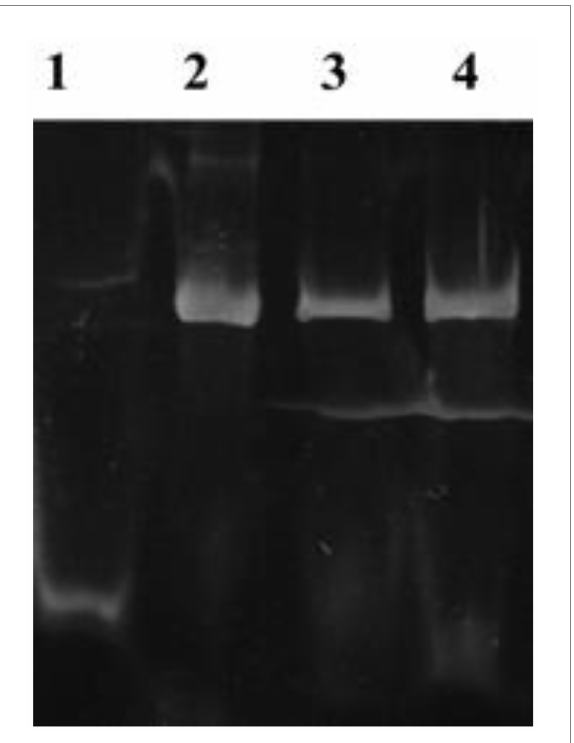
FIGURE 2 EMSA. Lame 1: GlnR protein without Pnir gene. Lame 2–4: The complex of GlnR protein binding to NiR promoter